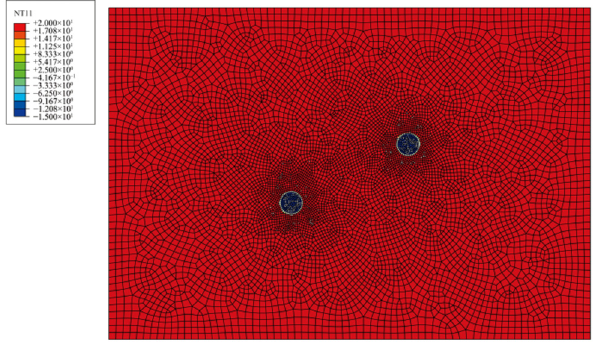
Figure 3. Simulation initial calculation diagram.